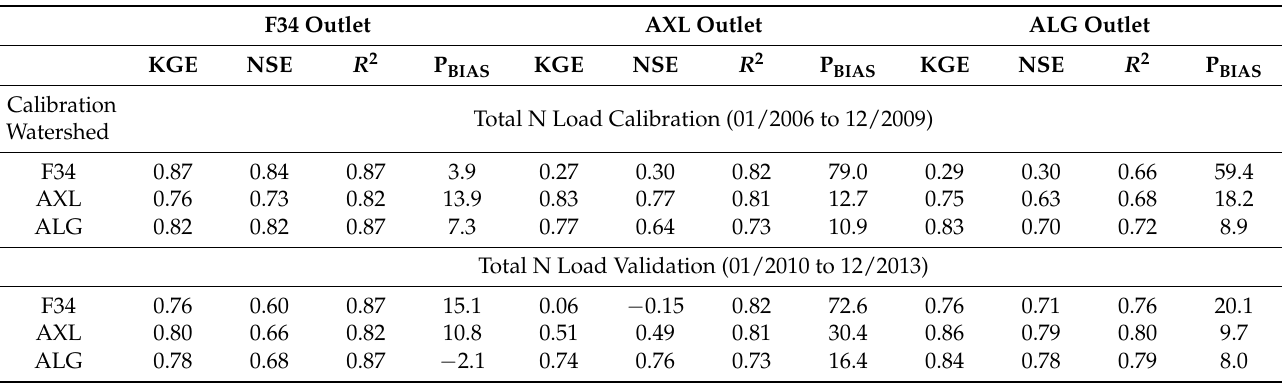
Table 10. Total N load calibration and validation statistical metrics for SWAT model performance for CCW, F34, AXL, and ALG.